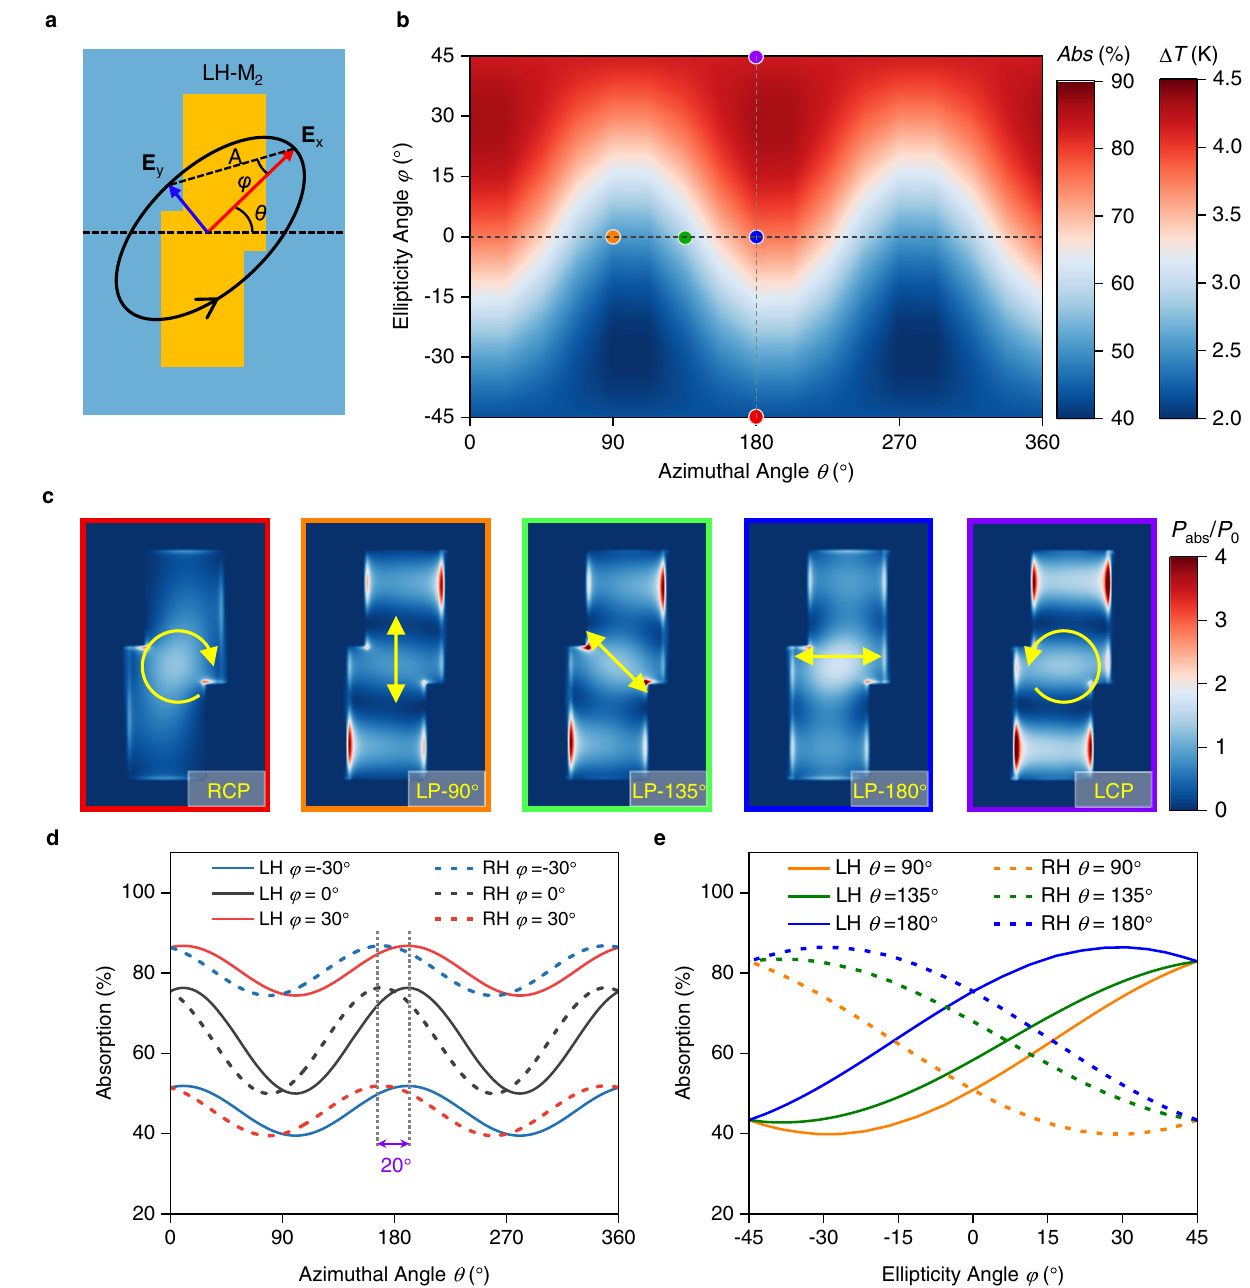
Fig. 2 | Polarization-dependent photothermal effect of the chiral metamater- ials.a Schematicof theLH-M 2 metamaterialand incidentpolarizedlightdescribed by the geometrical parameters of the ellipse. E x and E y denote the electric fi eld vector along the semi-major axis and semi-minor axis, respectively. θ denotes the angle between the semi-major axis of the polarization ellipse and the x-axis. φ denotes the ellipticity angle and equals to arctan E x / E y . b 2D contour map of both simulated absorbance and induced temperature increase for different light